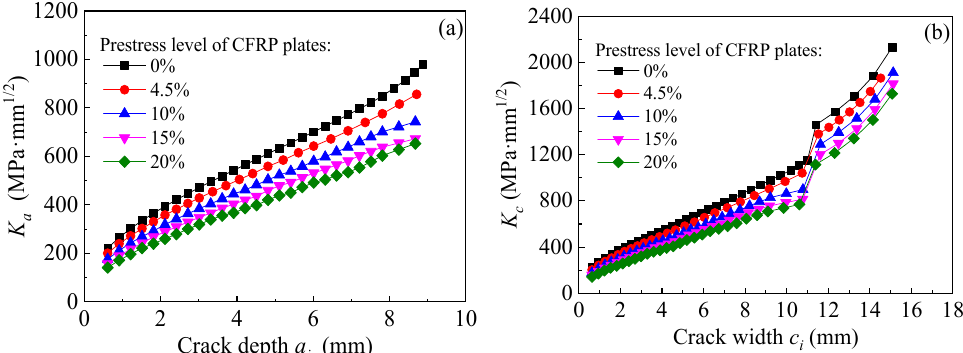
Figure 25. Effect of prestress level of CFRP plate on the K ‐ values at crack tip of the corroded steel plate strengthened with CFRP plates: ( a ) K a vs. crack depth a i and ( b ) K c vs. crack width c i .